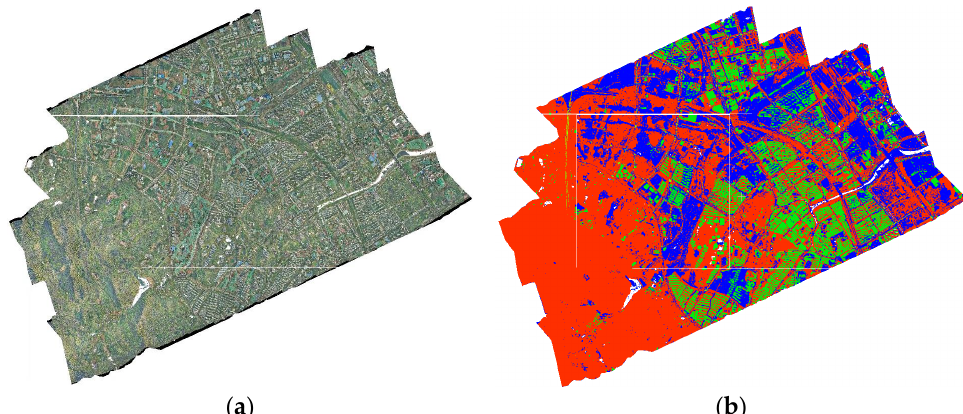
Figure 1. Original point cloud and labeled point cloud: ( a ) point cloud before labeling; ( b ) labeled point cloud.